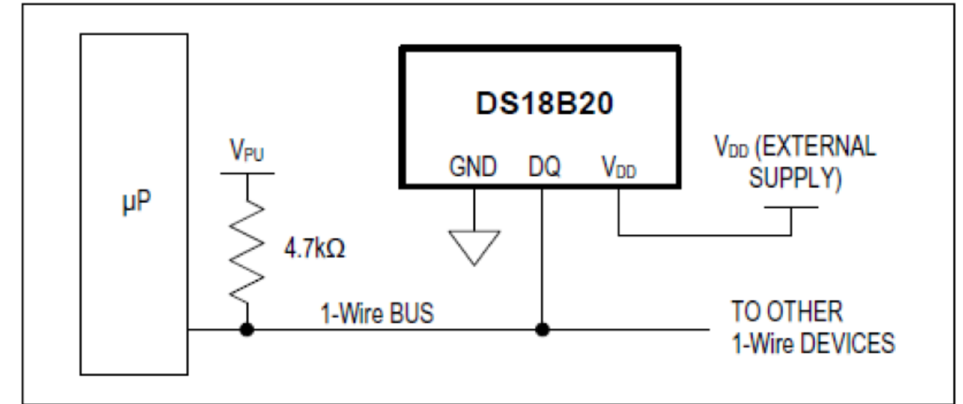
Figure 9. External power supply graphic representation [60].